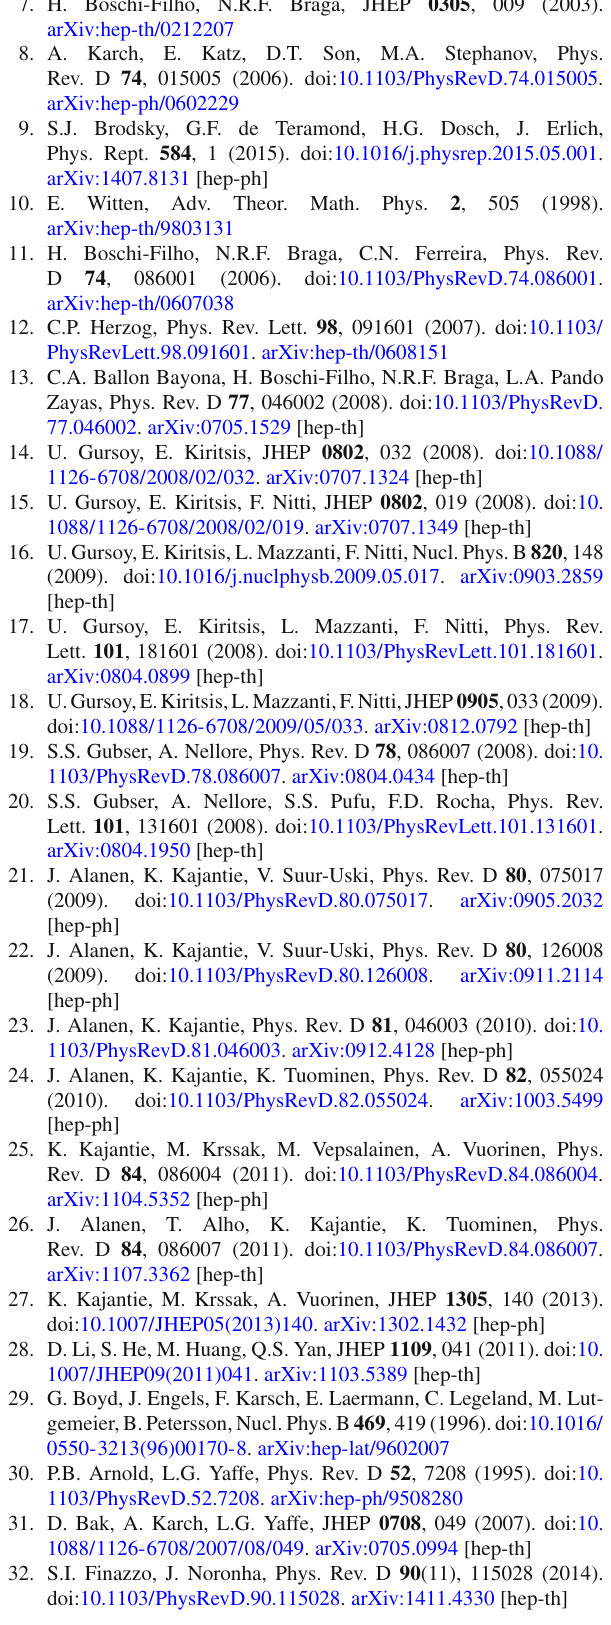
Fig. 6 Debye mass in GeV as a function of the temperature in MeV